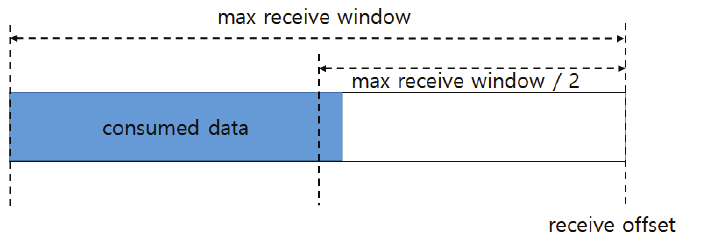
Figure 3. Transmission condition of MAX_STREAM_DATA